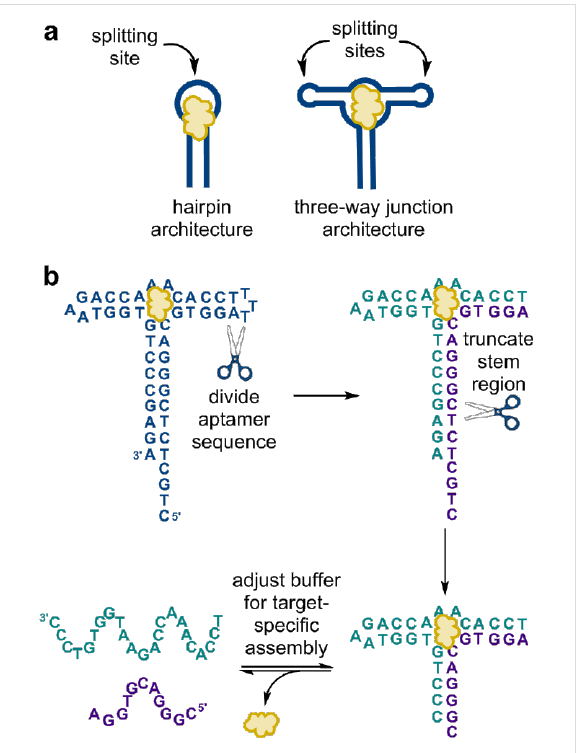
Figure 4: (a) In contrast to the more typical hairpin aptamer structure, we hypothesized that the three-way junction would provide a privi- leged architecture for generating split aptamers. (b) Split aptamers can be engineered by dividing a three-way junction aptamer, then system- atically truncating the stem region to fine tune the thermodynamics of assembly. Adapted with permission from [16]. Copyright (2013) Amer- ican Chemical